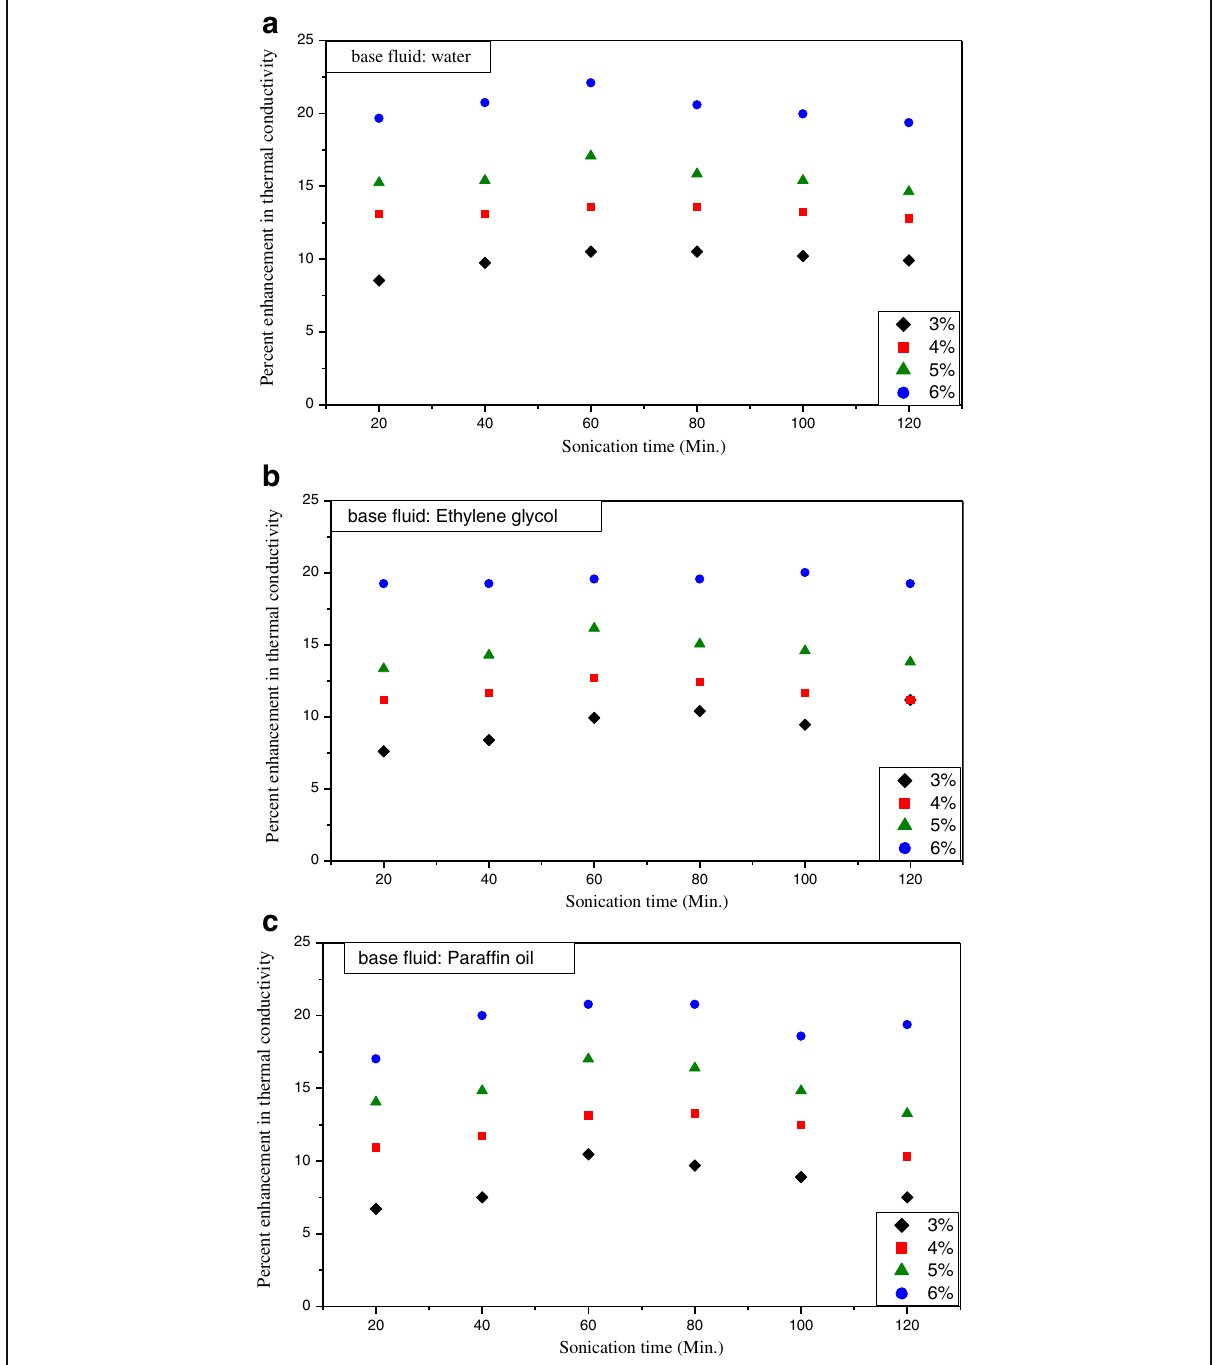
Fig. 5 The percent enhancement in thermal conductivity as a function of sonication time. a Base fluid: water. b Base fluid: ethylene glycol. c Base fluid: paraffin oil. Redrawn based on experimental data in reference